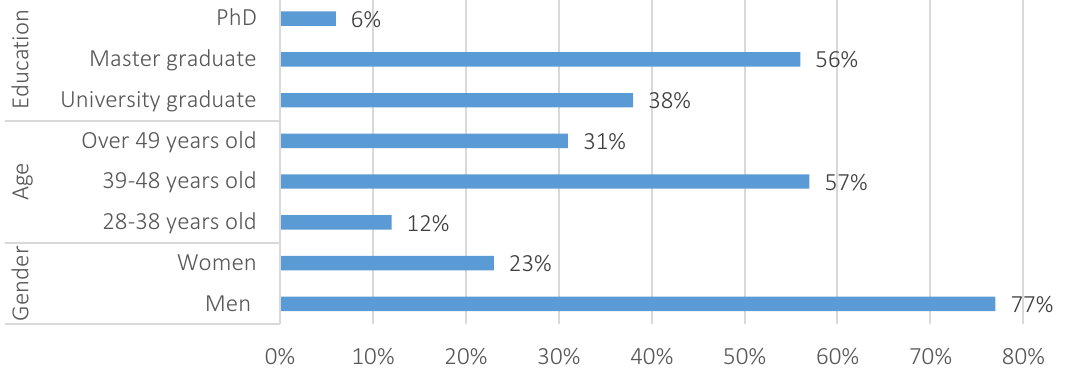
Table 1. Descriptive statistics on the influence of creative accounting on corporate performance